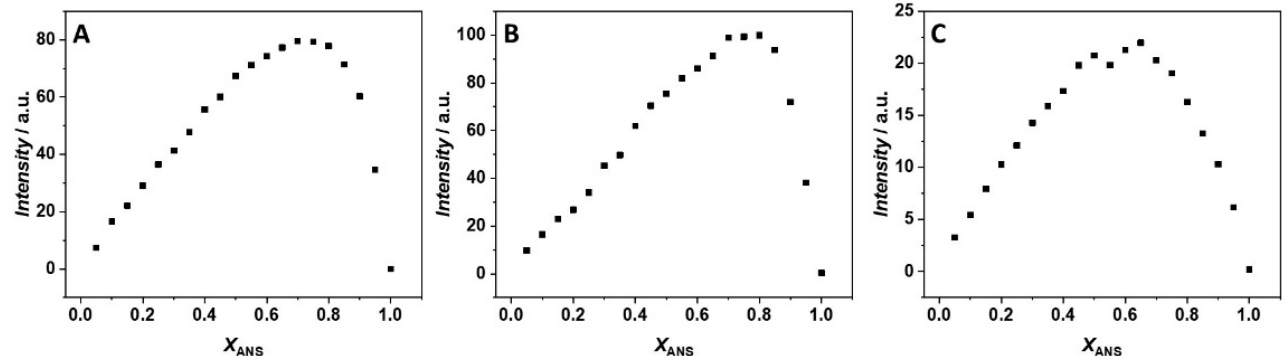
Figure 1. Job’s plot for ANS/BSA complex formation obtained at the temperature of 25 °C and pressure of 1 bar in the presence of 250 mM ( A ) MgCl 2 , ( B ) MgSO 4 , and ( C ) Mg(ClO 4 ) 2. The total concentration ([ANS] + [BSA]) was 35 µM. The fluorescence intensity is reported in arbitrary units (a.u.).